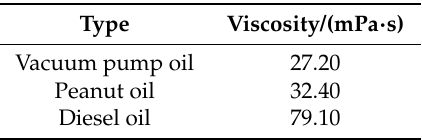
Table 1. Viscosity of different types of oil. Figure 8. Maximum oil absorption capacity of porous membranes with different diameters for different kinds of oil.